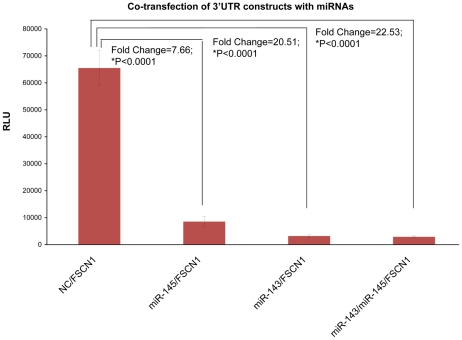
Luciferase reporter assay for 3′UTR of FSCN1 regulated by miR-143 and miR-145.Bar represents the RLU of negative control (NC), miR-145 mimic, miR-143 mimic, or miR-143 and miR-145 mimic mixture co-transfected with 3′UTR constructs of FSCN1. Asterisk (*) shows the statistically significant difference between negative control treatment and miRNA mimic treatment with ANOVA analysis based on factorial experiment design. Fold change shows the ratio of RLU from negative control treatment divided by RLU from miRNA mimic treatment.